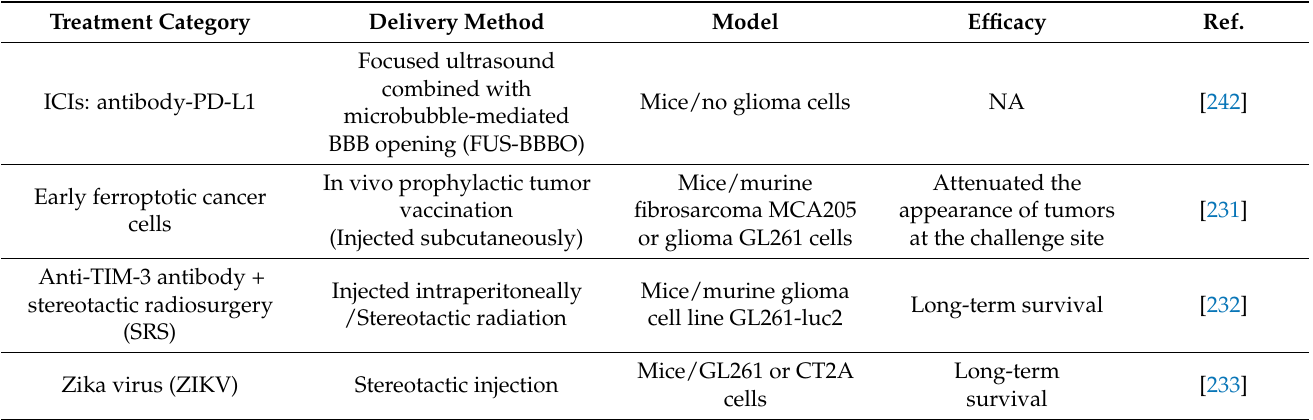
Table 3. Preclinical studies of induction of ICD to enhance the immunotherapy of